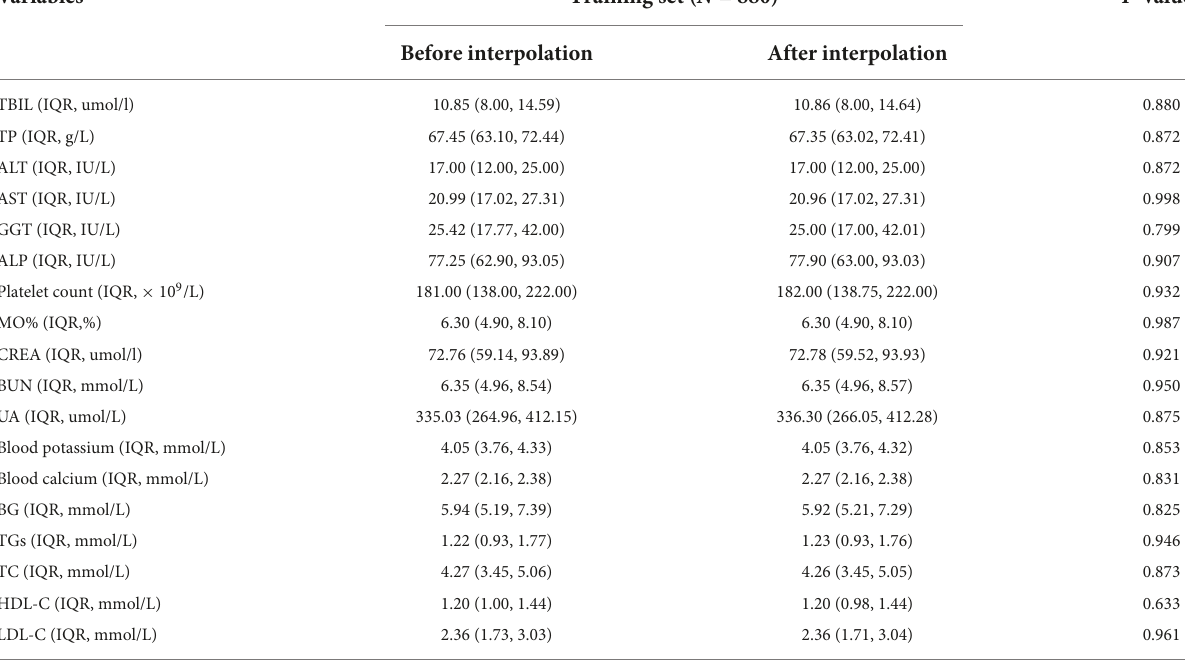
TABLE 2 Comparison of continuous variables in the training set before and after multiple imputation.